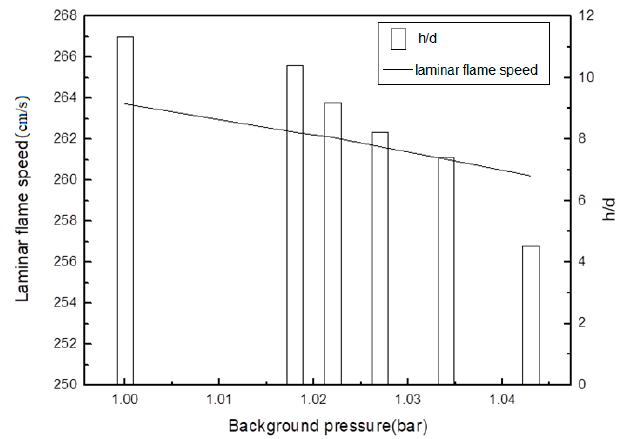
Figure 9. Calculated laminar flame speed vs. background pressure.